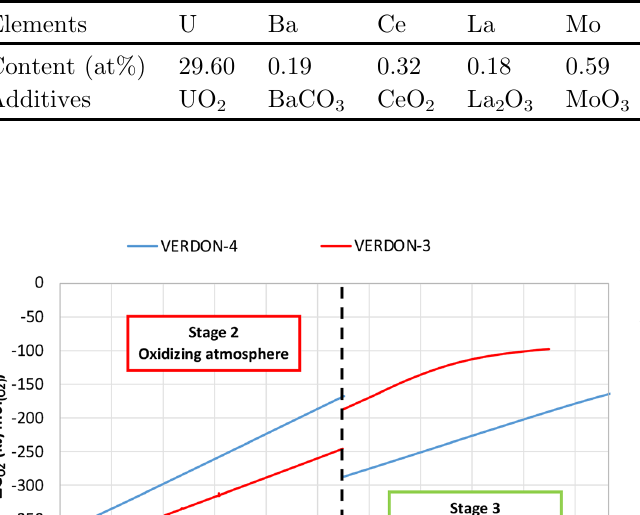
Table 1. Final composition of the SIMFuel samples (the difference to 100% is due to the O content) and description of the additives used to synthesize the SIMFuel